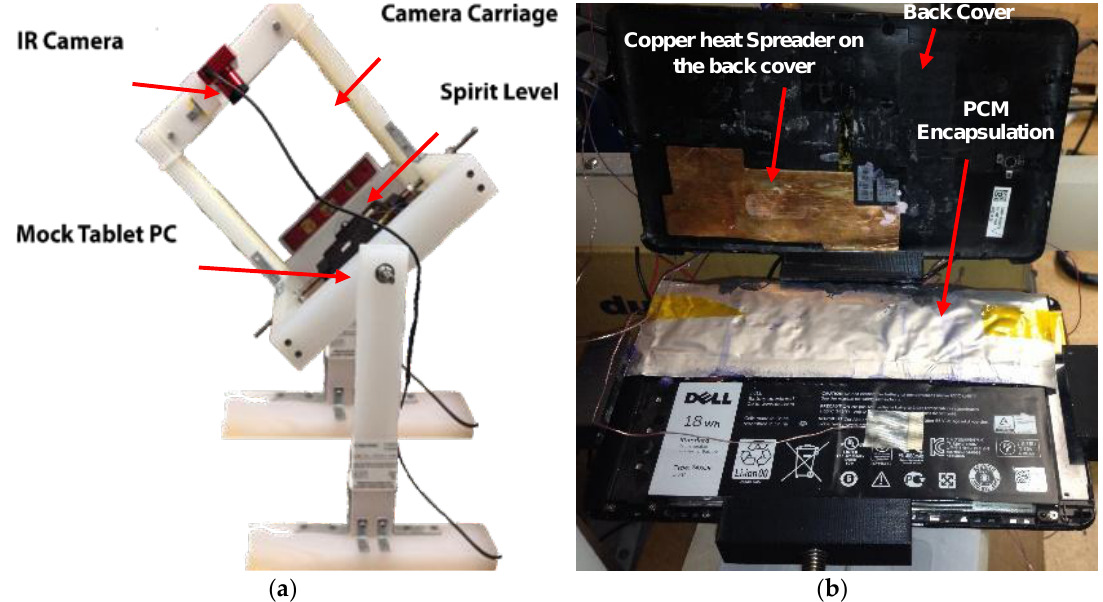
Figure 1. Photograph of the experimental setup showing ( a ) the inclined test stand and ( b ) the mock tablet PC with Size 2 PCM (phase change material) encapsulation on display. IR: Infrared.